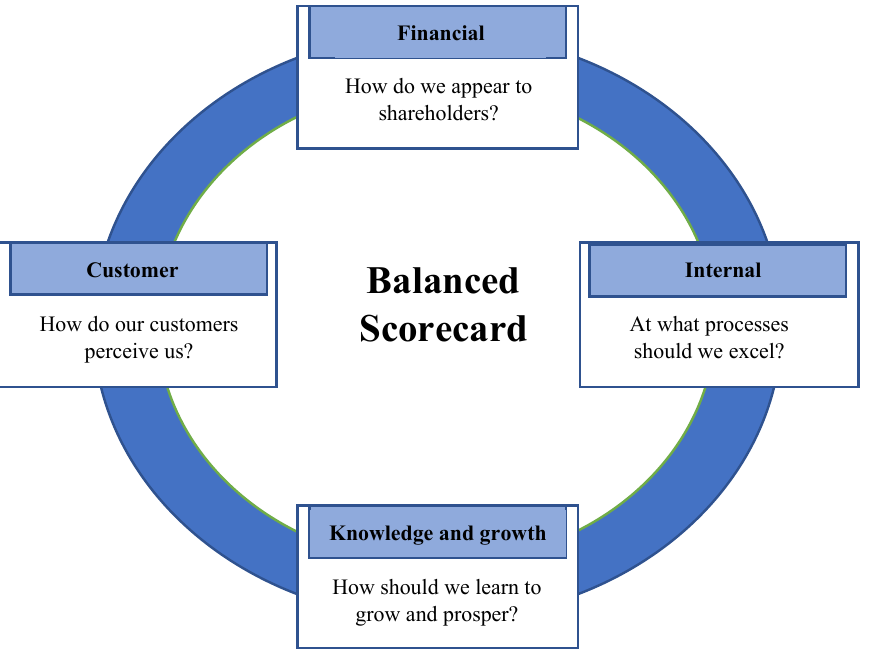
Figure 1. Balanced scorecard perspectives [11] Figure 1. Balanced Scorecard perspectives